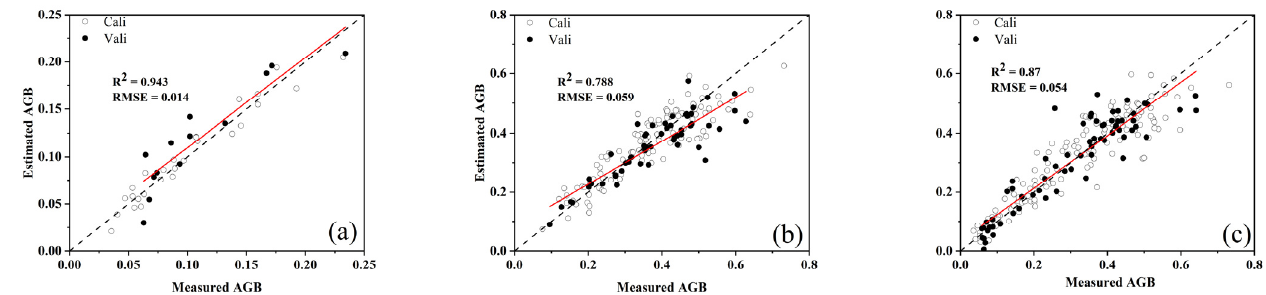
Figure 12. Validation of aboveground biomass (AGB) estimation models established by best performing optimal normalized difference texture index subset vs. AGB for the following stages: ( a ) seedling, ( b ) post-seedling, ( c ) all stages.